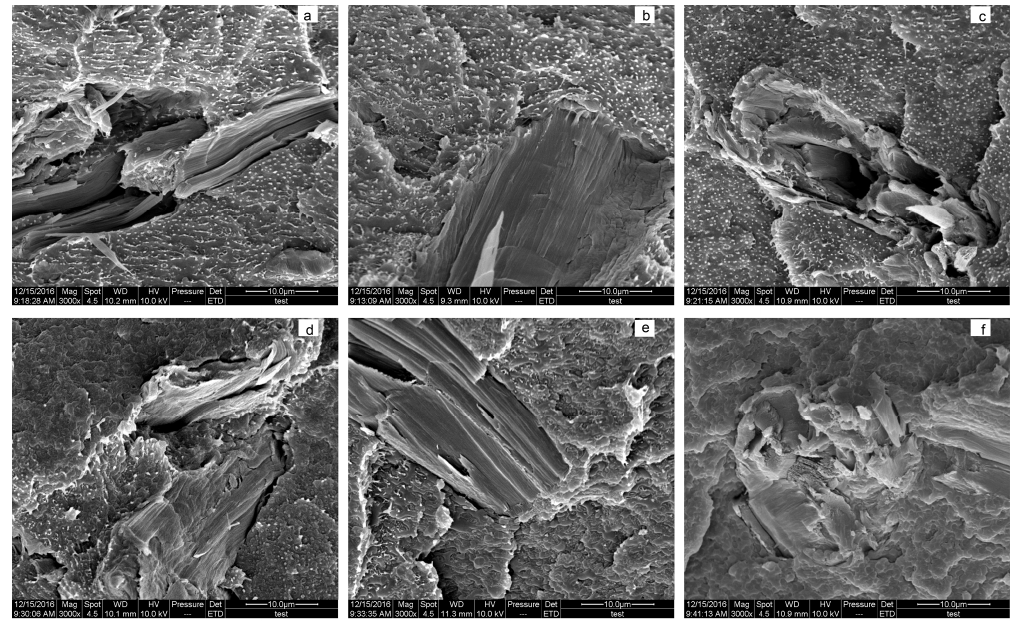
Figure 5. Cont. Figure 5. Cont.